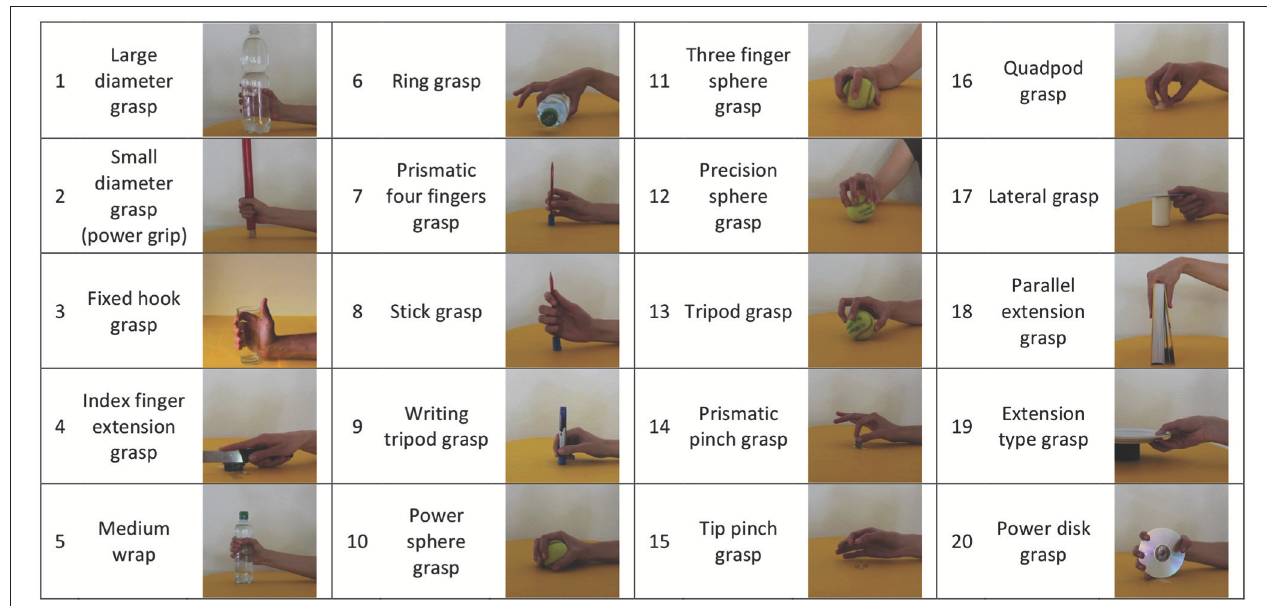
FIGURE 3 | The 20 grasps considered in this study are shown. They provide a comprehensive mapping of the repertoire of hand grasps available to human subjects, and are stored in the publicly available Ninapro